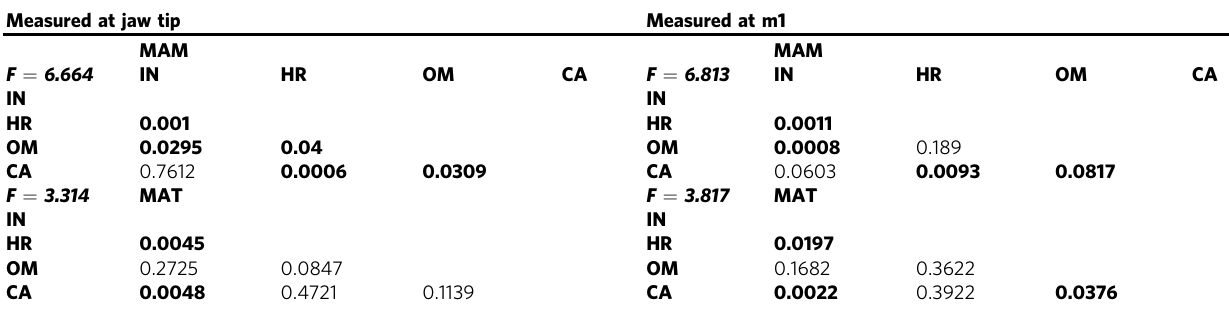
Table 3 Pairwise p values (uncorrected signi fi cance) of one-way PERMANOVAs of the mechanical advantage values of the masseter (MAM) and temporalis (MAT) obtained in this study on extant taxa of known dietary preferences only (permutation N = 9999). Measured at jaw tip